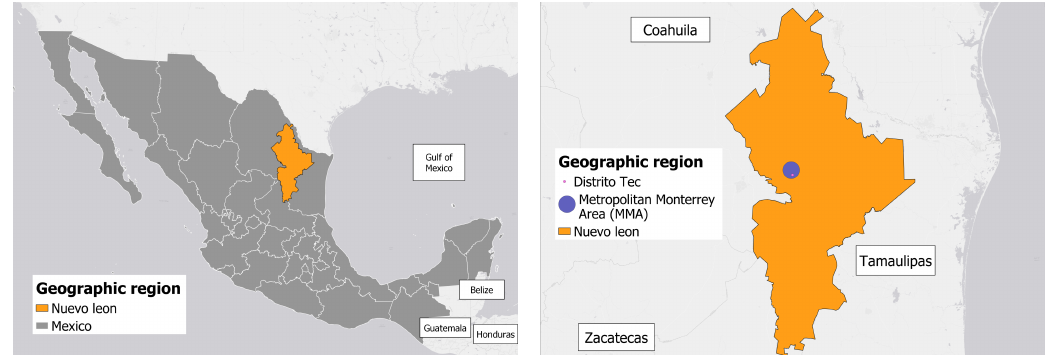
Figure 1. Case study geographical